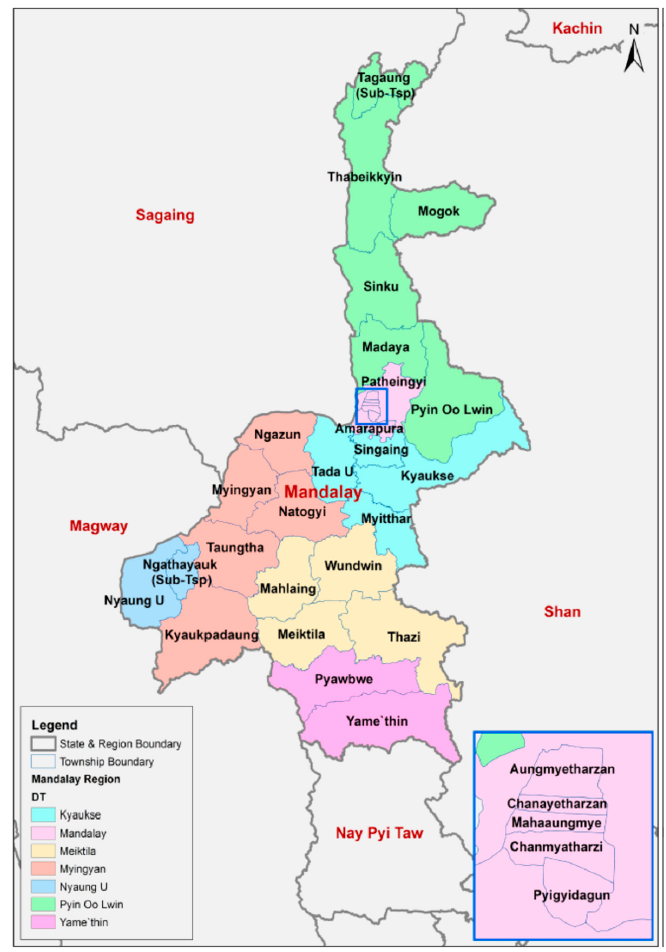
Figure 3. Map of Mandalay region [61].